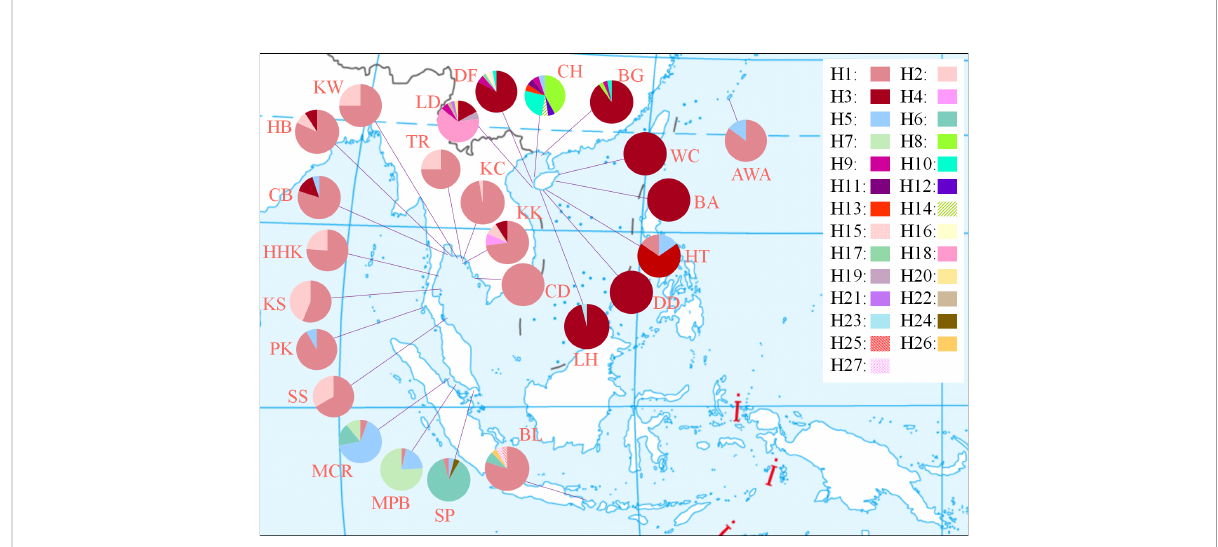
FIGURE 2 Geographic distribution and relative frequency of 27 mitochondrial cox 1 haplotypes in 25